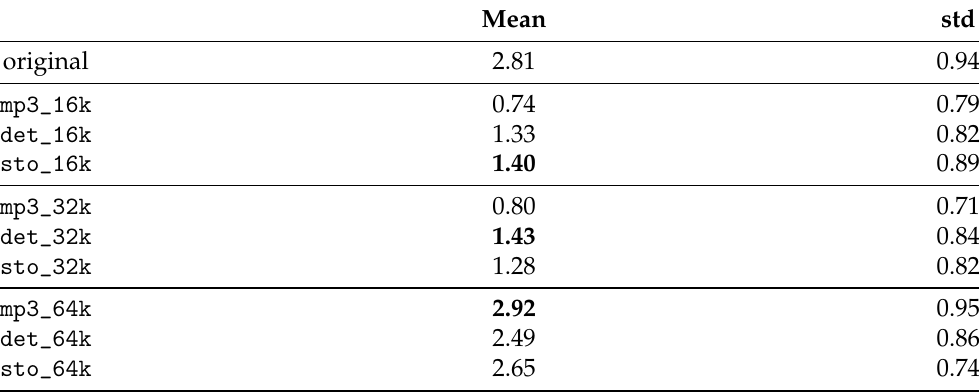
Table 3. Mean Opinion Score (MOS) of absolute ratings for different compression rates. We compare the stochastic ( sto ) versions against the deterministic baselines ( det ), the MP3-encoded lower anchors ( mp3 ) and the original high-quality audio